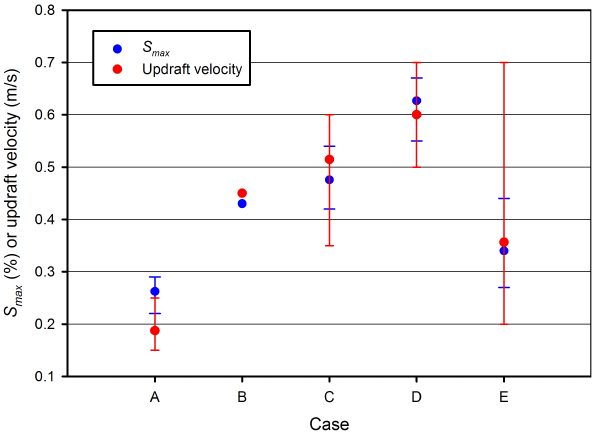
Fig. 8. Calculated maximum supersaturation and the estimated up- draft velocity for each cloud event. The symbols represent average values and the bars indicate the minimum and maximum values of the quantity during the